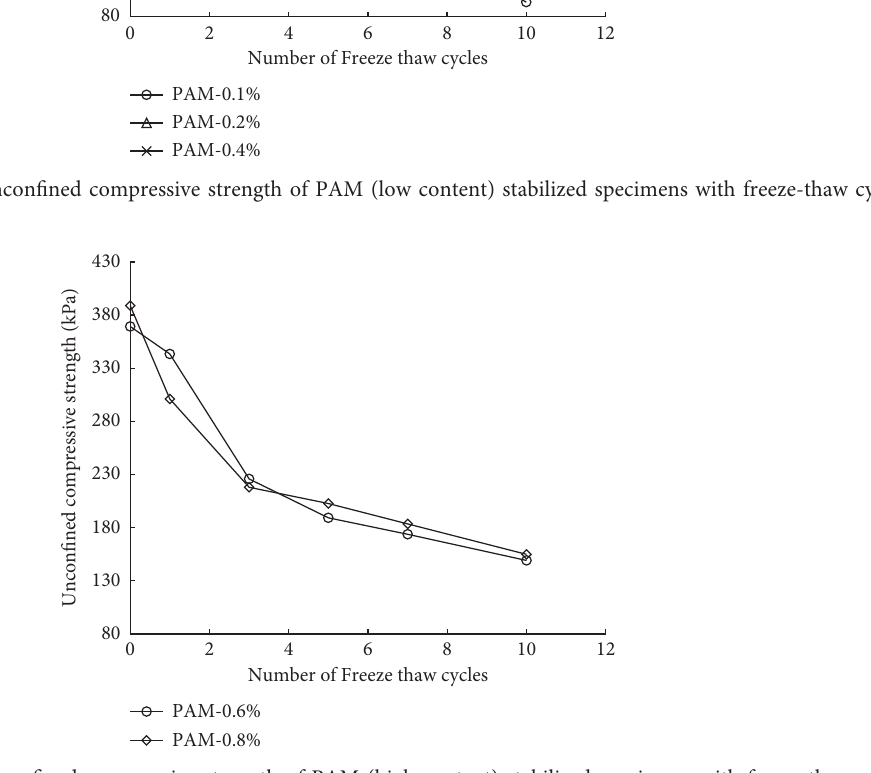
Figure 19: Changes of unconfined compressive strength of PAM (high content) stabilized specimens with freeze-thaw